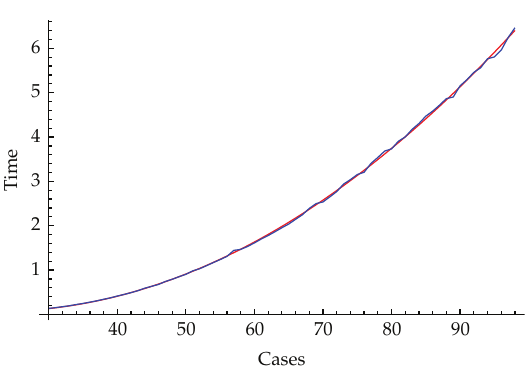
Figure 2: CPU-time in seconds taken by KTEF - S as a function of the number of processed cases for a 50-asset instance, with its least-square quadratic approximation